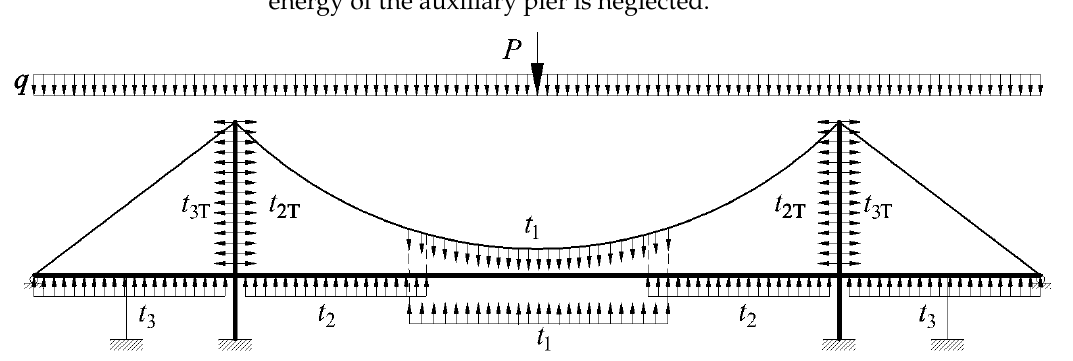
Figure 2. Simplified combined cable-stayed suspension system.